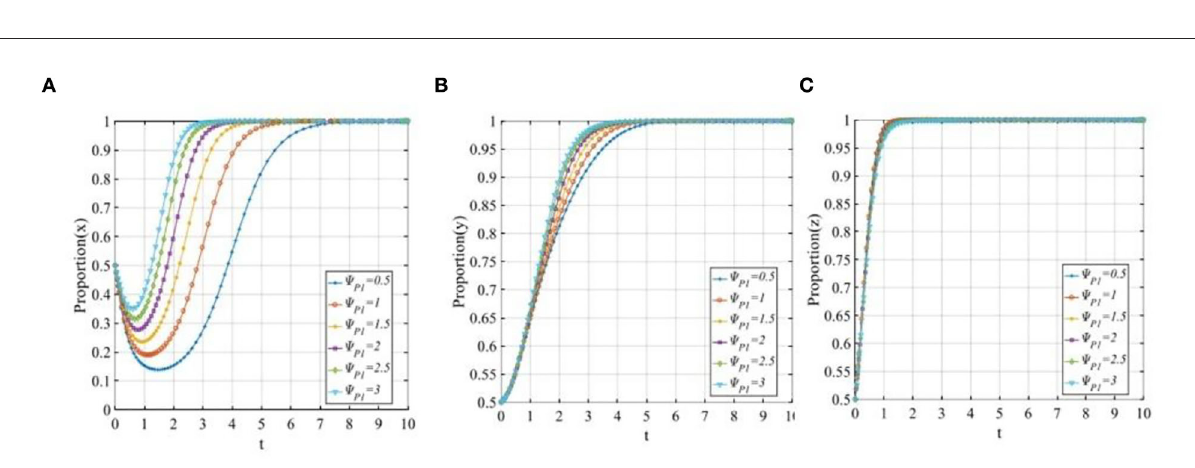
FIGURE9 The sensitivity analysis of the reputation benefits of P2P lending platforms when ψ P 1 = 0.5, 1, 1.5, 2, 2.5, 3. (A) The sensitivity of P2P lending platforms; (B) The sensitivity of investors; and (C) The sensitivity of financial